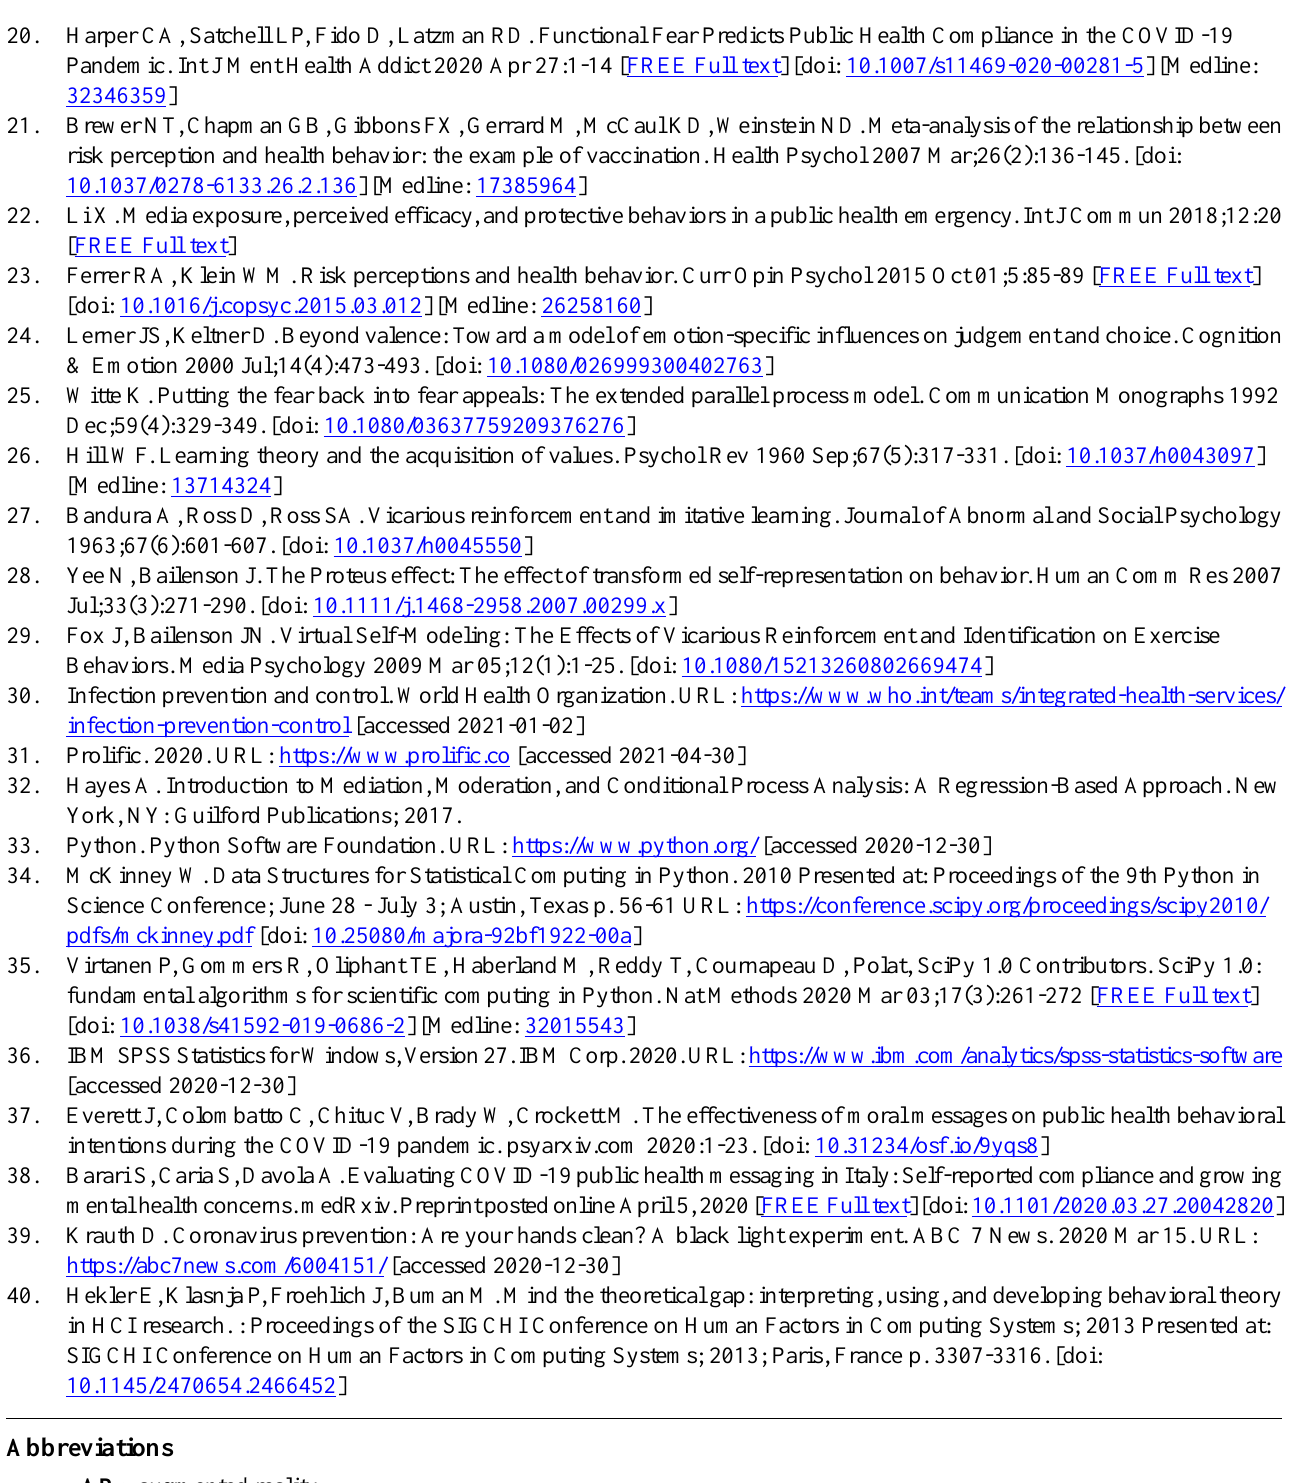
CDC: Centers for Disease Control and Prevention EPPM: Extended Parallel Process